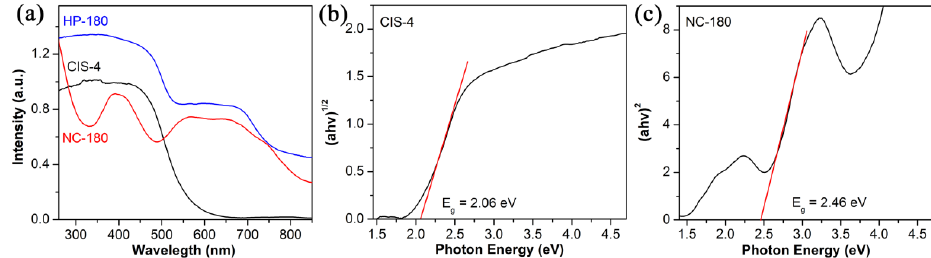
Figure 5. ( a ) UV ‐ Vis absorption spectra of CIS ‐ 4, NC ‐ 180 and HP ‐ 180; ( b , c ) Tauc ‐ plots of CIS ‐ 4 and NC ‐ 180,